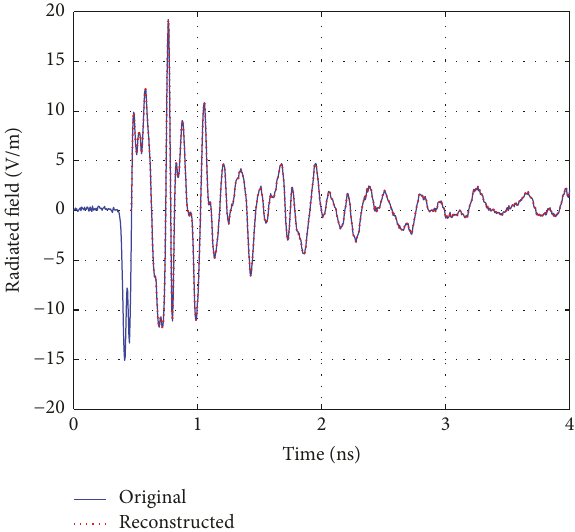
Figure 26: Comparison of the original measured impulse response and the reconstructed response of the microstrip